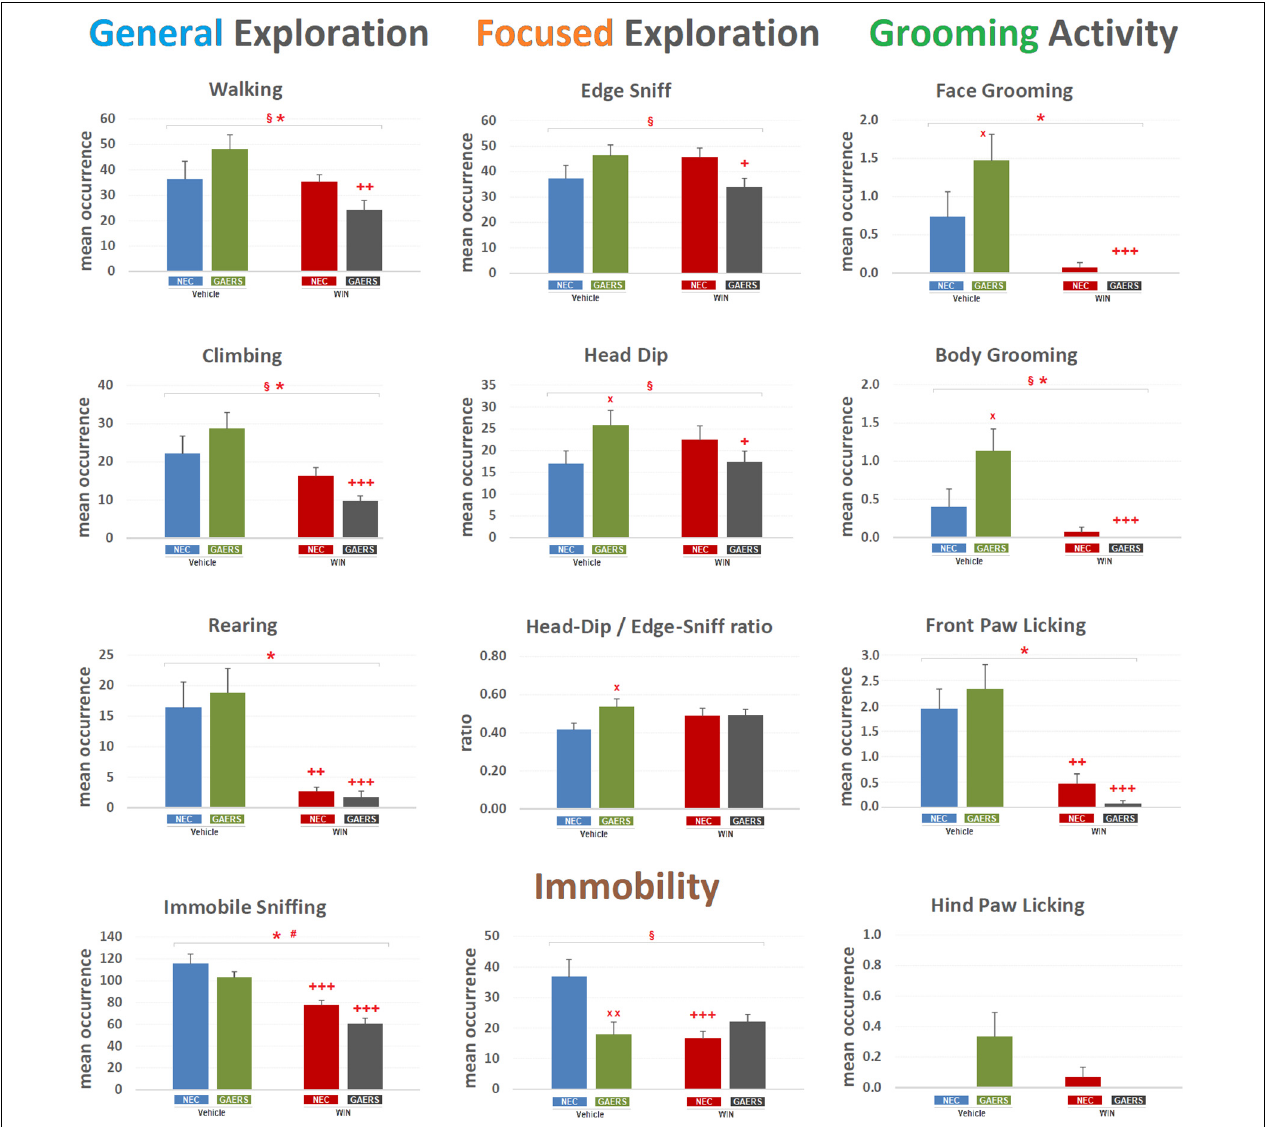
FIGURE 2 | Effect of WIN 55,212-2 and its vehicle on the occurrence of different behaviors of Genetic Absence Epilepsy Rats from Strasbourg (GAERS) and non-epileptic control (NEC) rats. Administration of WIN 55,212-2 (WIN; 2 mg/kg, IP ) and its vehicle affected the mean occurrence ± SEM of several behaviors of GAERS and NEC rats detected during the 10 min of the hole-board test. § = significant ( p < 0.05) interaction between factors (strain x treatment, two-way ANOVA); * = significant ( p < 0.05) main effect of pharmacological treatment (WIN vs. Vehicle, two-way ANOVA). # = significant ( p < 0.05) effect of strain (GAERS vs. NEC, two-way ANOVA). x = significant difference between GAERS Vehicle vs. NEC Vehicle (Fisher’s LSD post hoc test for multiple comparisons). + = significant difference between GAERS WIN vs. GAERS Vehicle or between NEC WIN vs. NEC Vehicle (Fisher’s LSD post hoc test for multiple comparisons). x = p < 0.05, xx = p < 0.01; + = p < 0.05, ++ = p < 0.01 +++ = p < 0.001 . Data obtained from the analysis of four groups ( n = 15 subjects in each